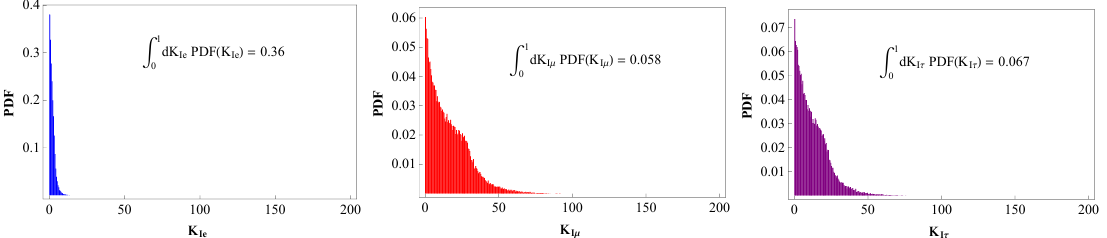
Figure 6. Same as in (cid:12)gure 5 but using the experimental values of the mixing angles in eq. (3.12).